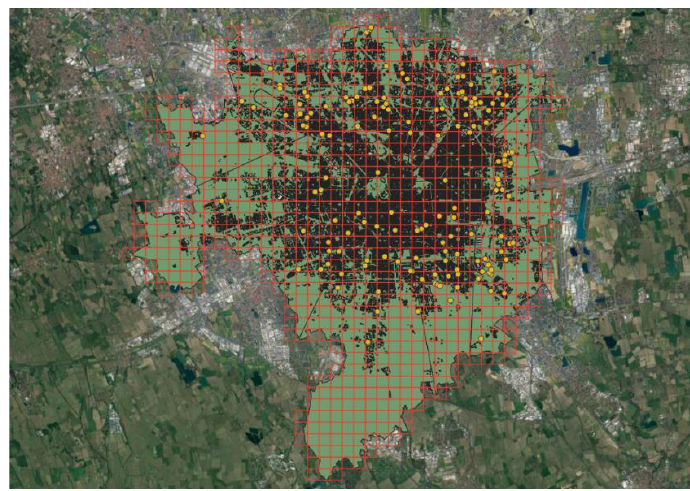
Figure 10. Location of green areas and disused or abandoned buildings (yellow points).